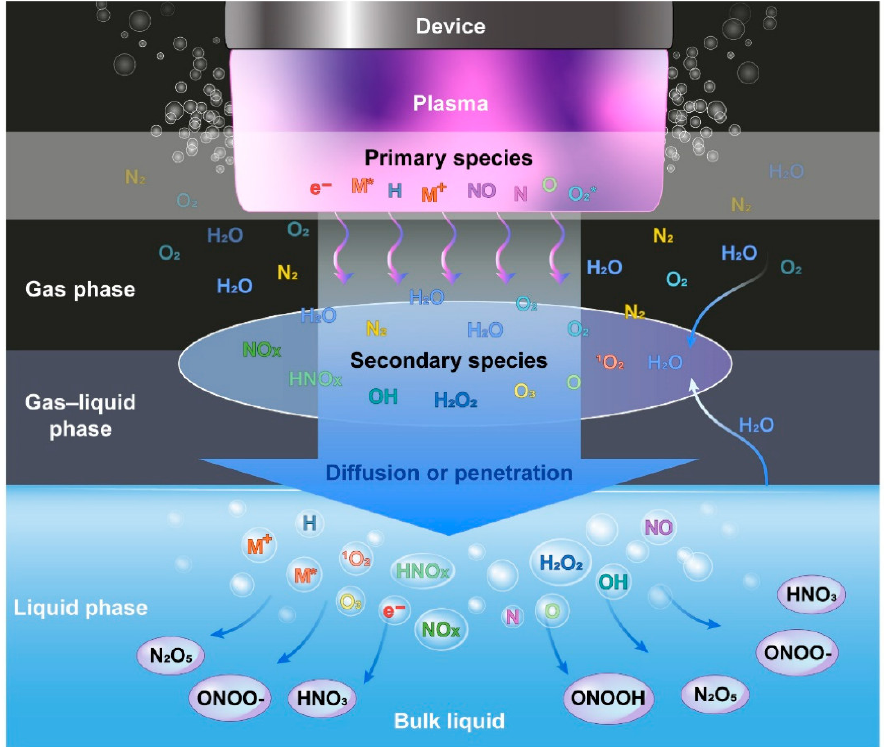
Figure 3. Graphical representation of formation of reactive species in plasma discharge, gas phase, gas–liquid phase, and liquid phase [38].